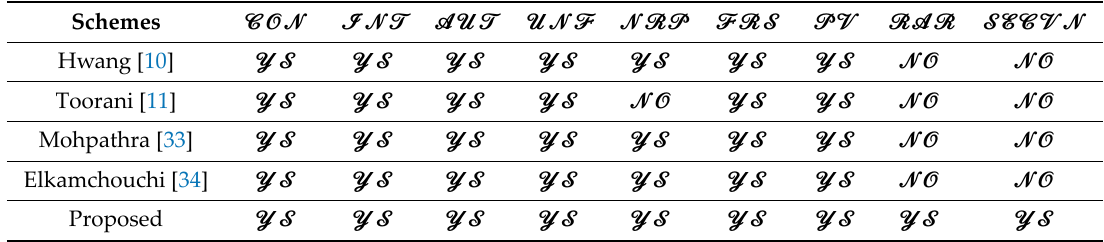
Table 1. Comparison in term of security requirements.